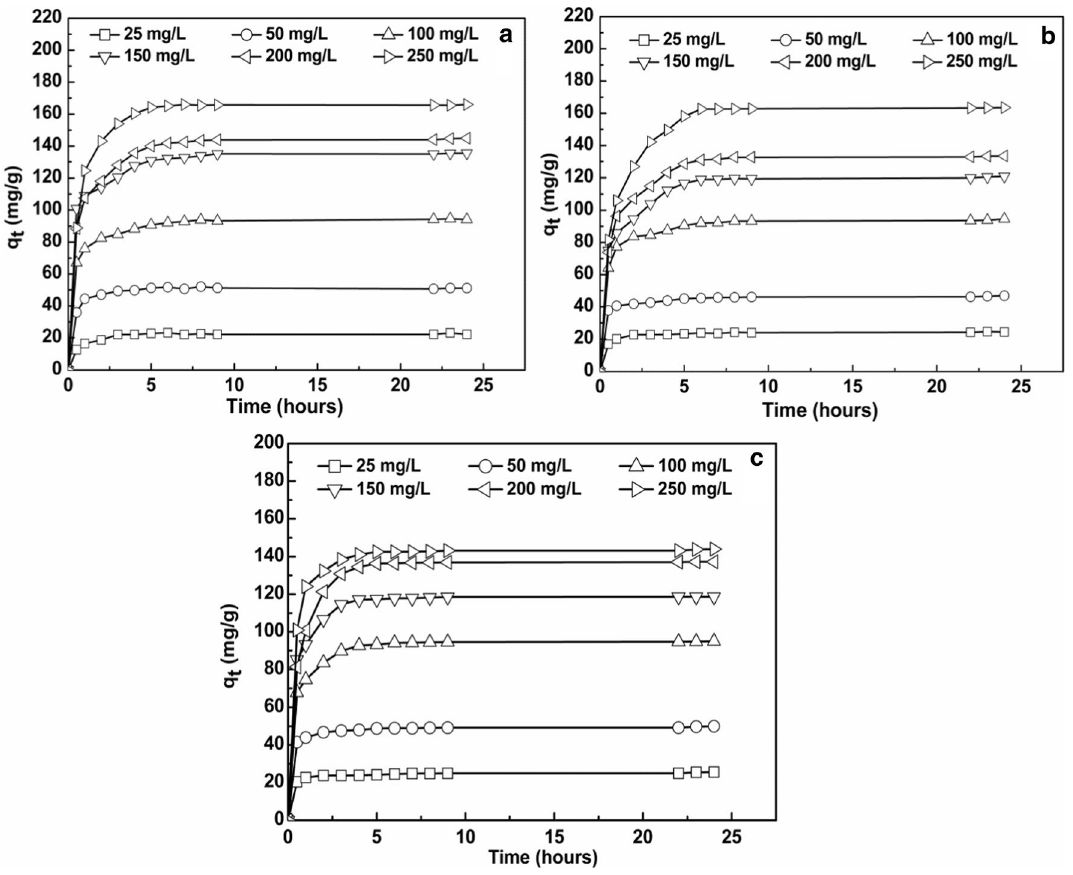
Fig. 4 Effects of contact time and initial concentration on the removal of MB onto BNH-CM at 30° ( a ), 40° ( b ) and 50 °C ( c ) at initial pH 6.7 and adsorbent dosage 0.2